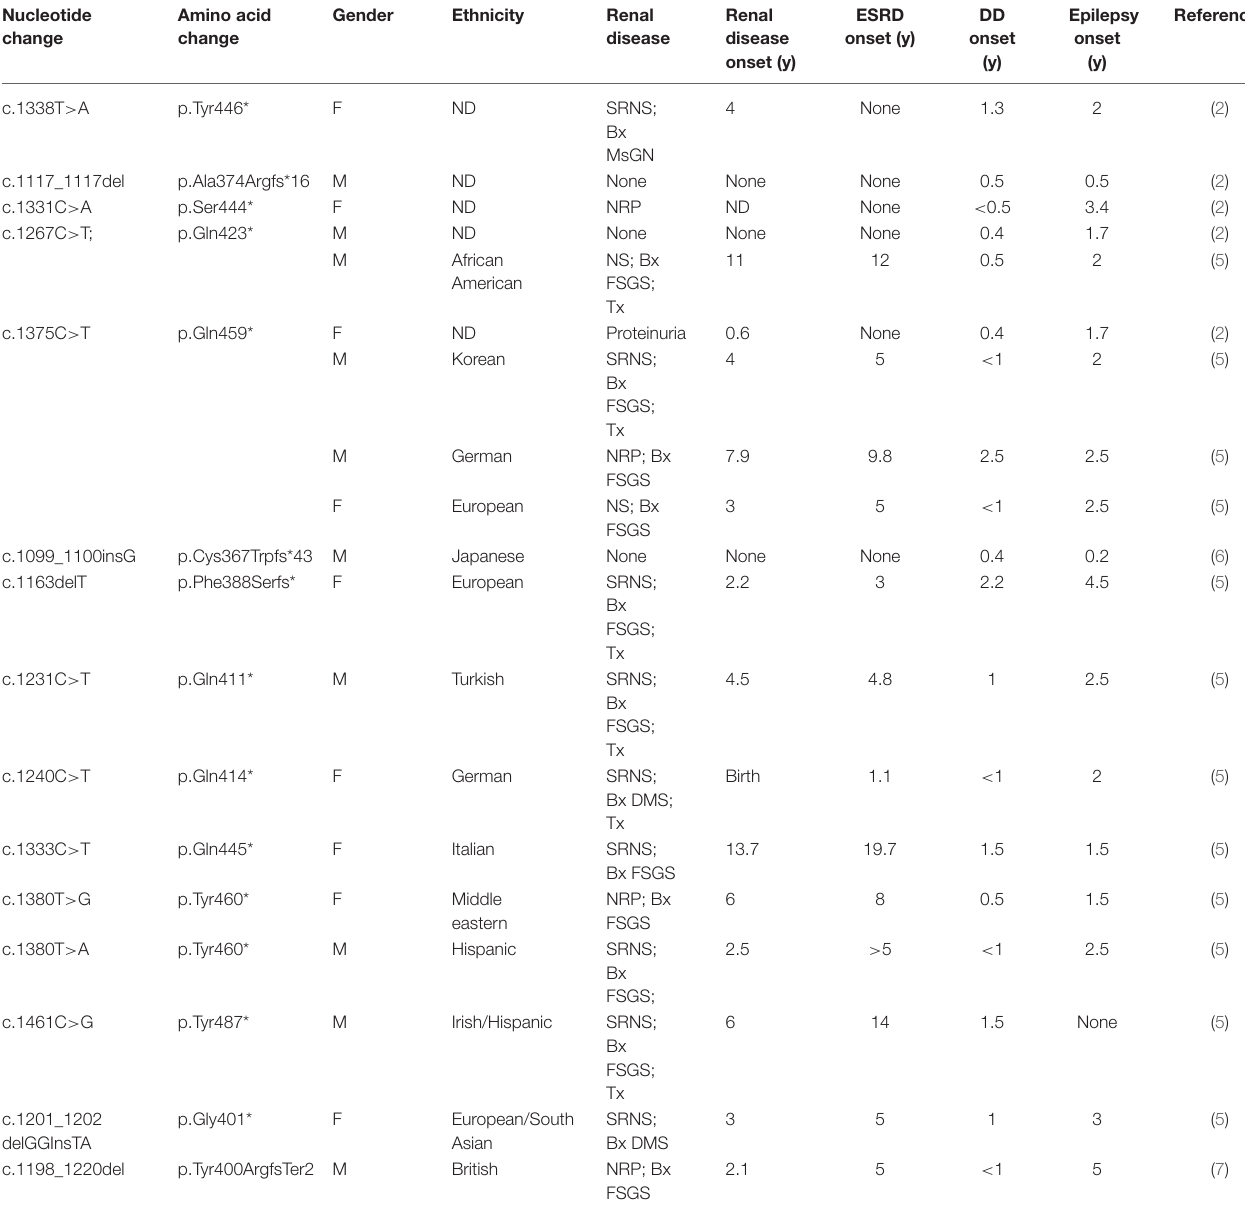
TABLE 1 | Mutations in exon 6 of the TRIM8 gene have been reported. Nucleotide